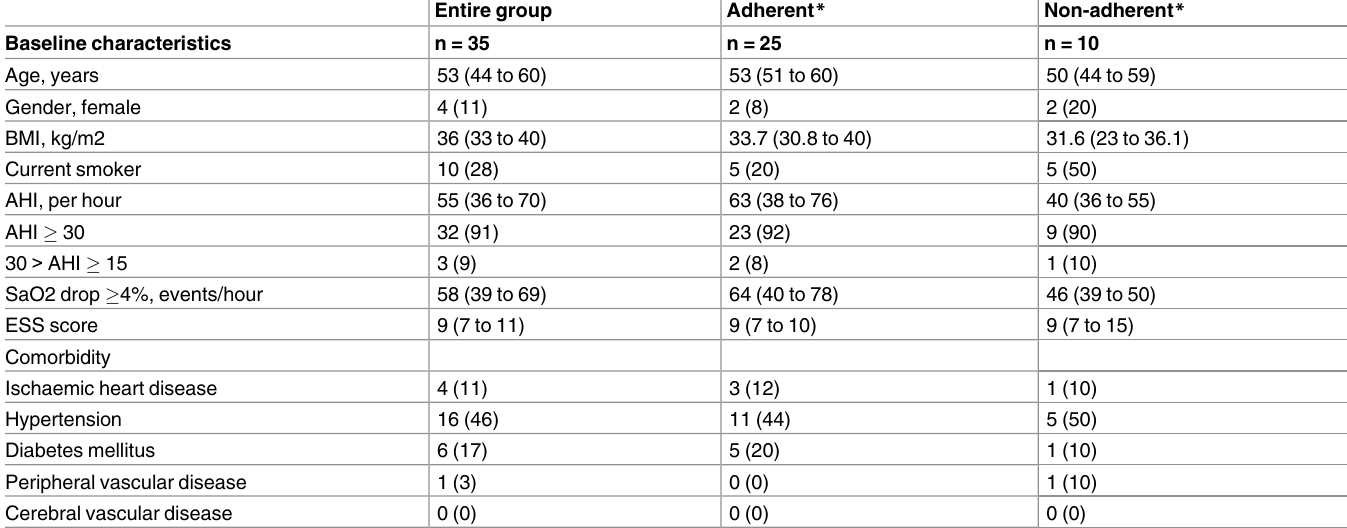
Table 1. Demographic and clinical data of the study population.